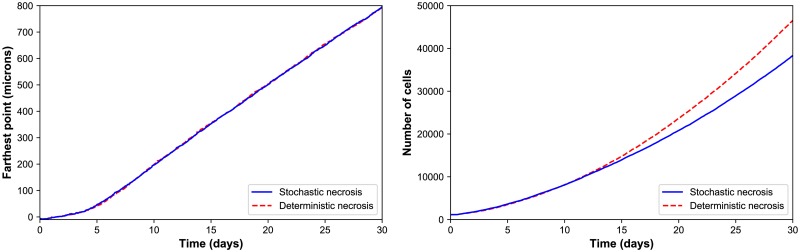
DCIS growth.The deterministic and stochastic necrosis models both result in linear DCIS growth at approximately 1 cm/year (left), even while their cell counts differ by 21% by the end of the simulations (right).